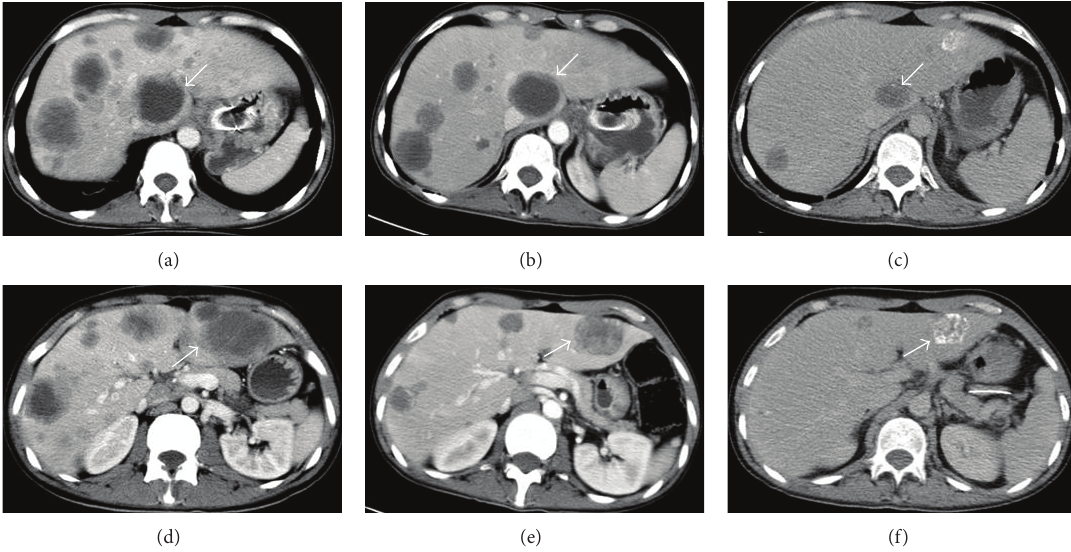
Figure 2: In different sections (above and bottom) regressing of metastatic lesions in the liver ((a) and (d), at onset; (b) and (e), October; (c) and (f), December); note the calcifications in (c) and